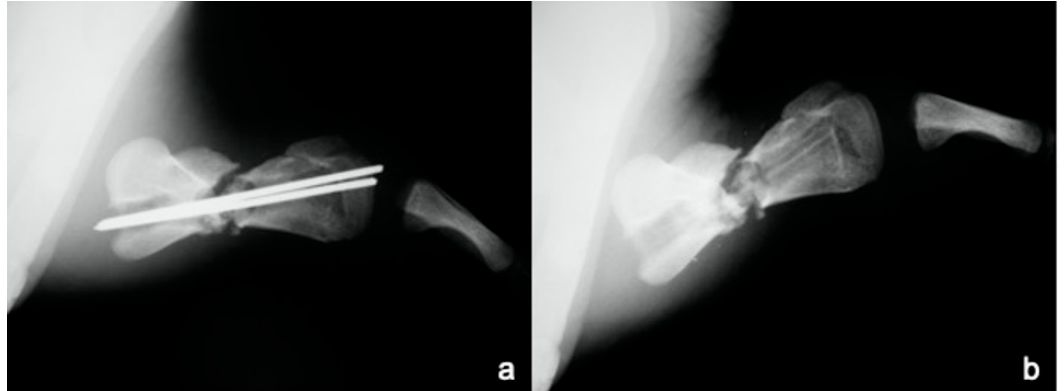
Figure 5. Postoperative checkup at four month: Caudocranial view of the anterior right flipper showed a complete repair of the epiphyseal fracture while the diaphyseal fracture still lacked unifying callus tissue.